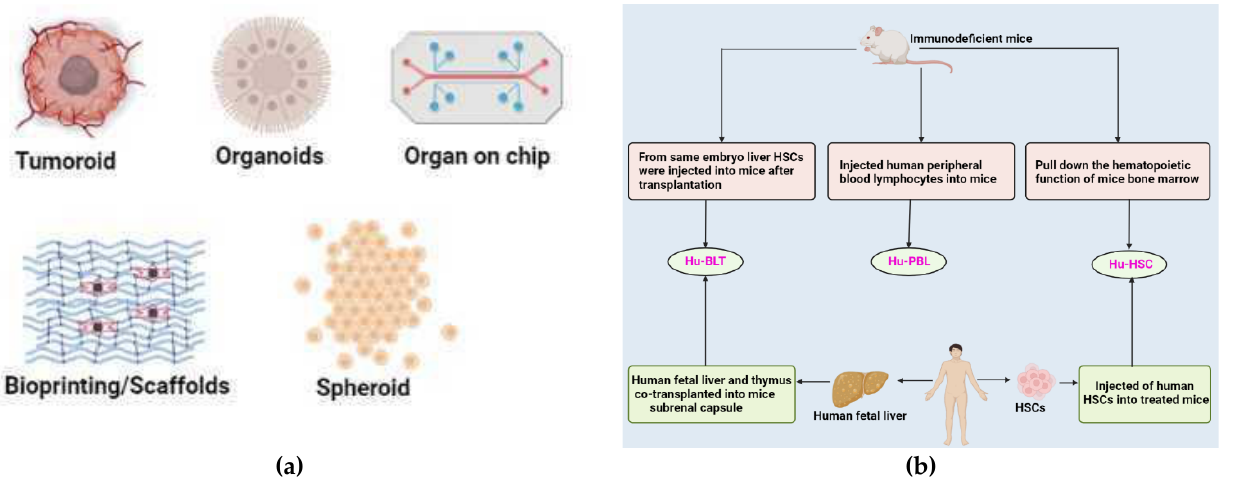
Figure 3. Lung cancer models: ( a) 3D models currently used to study Lung cancer, cancer stroma, and immunotherapy effects. ( b ) The humanized mouse model of the human immune system involves implanting human hematopoietic cells, lymphocytes, or organs into immunodeficient mice to recreate the human immune system for cancer studies. Hu-BLT, human bone marrow, liver, and thymus; Hu-HSC, human hematopoietic stem cell; Hu-PBL, human peripheral blood lymphocyte.